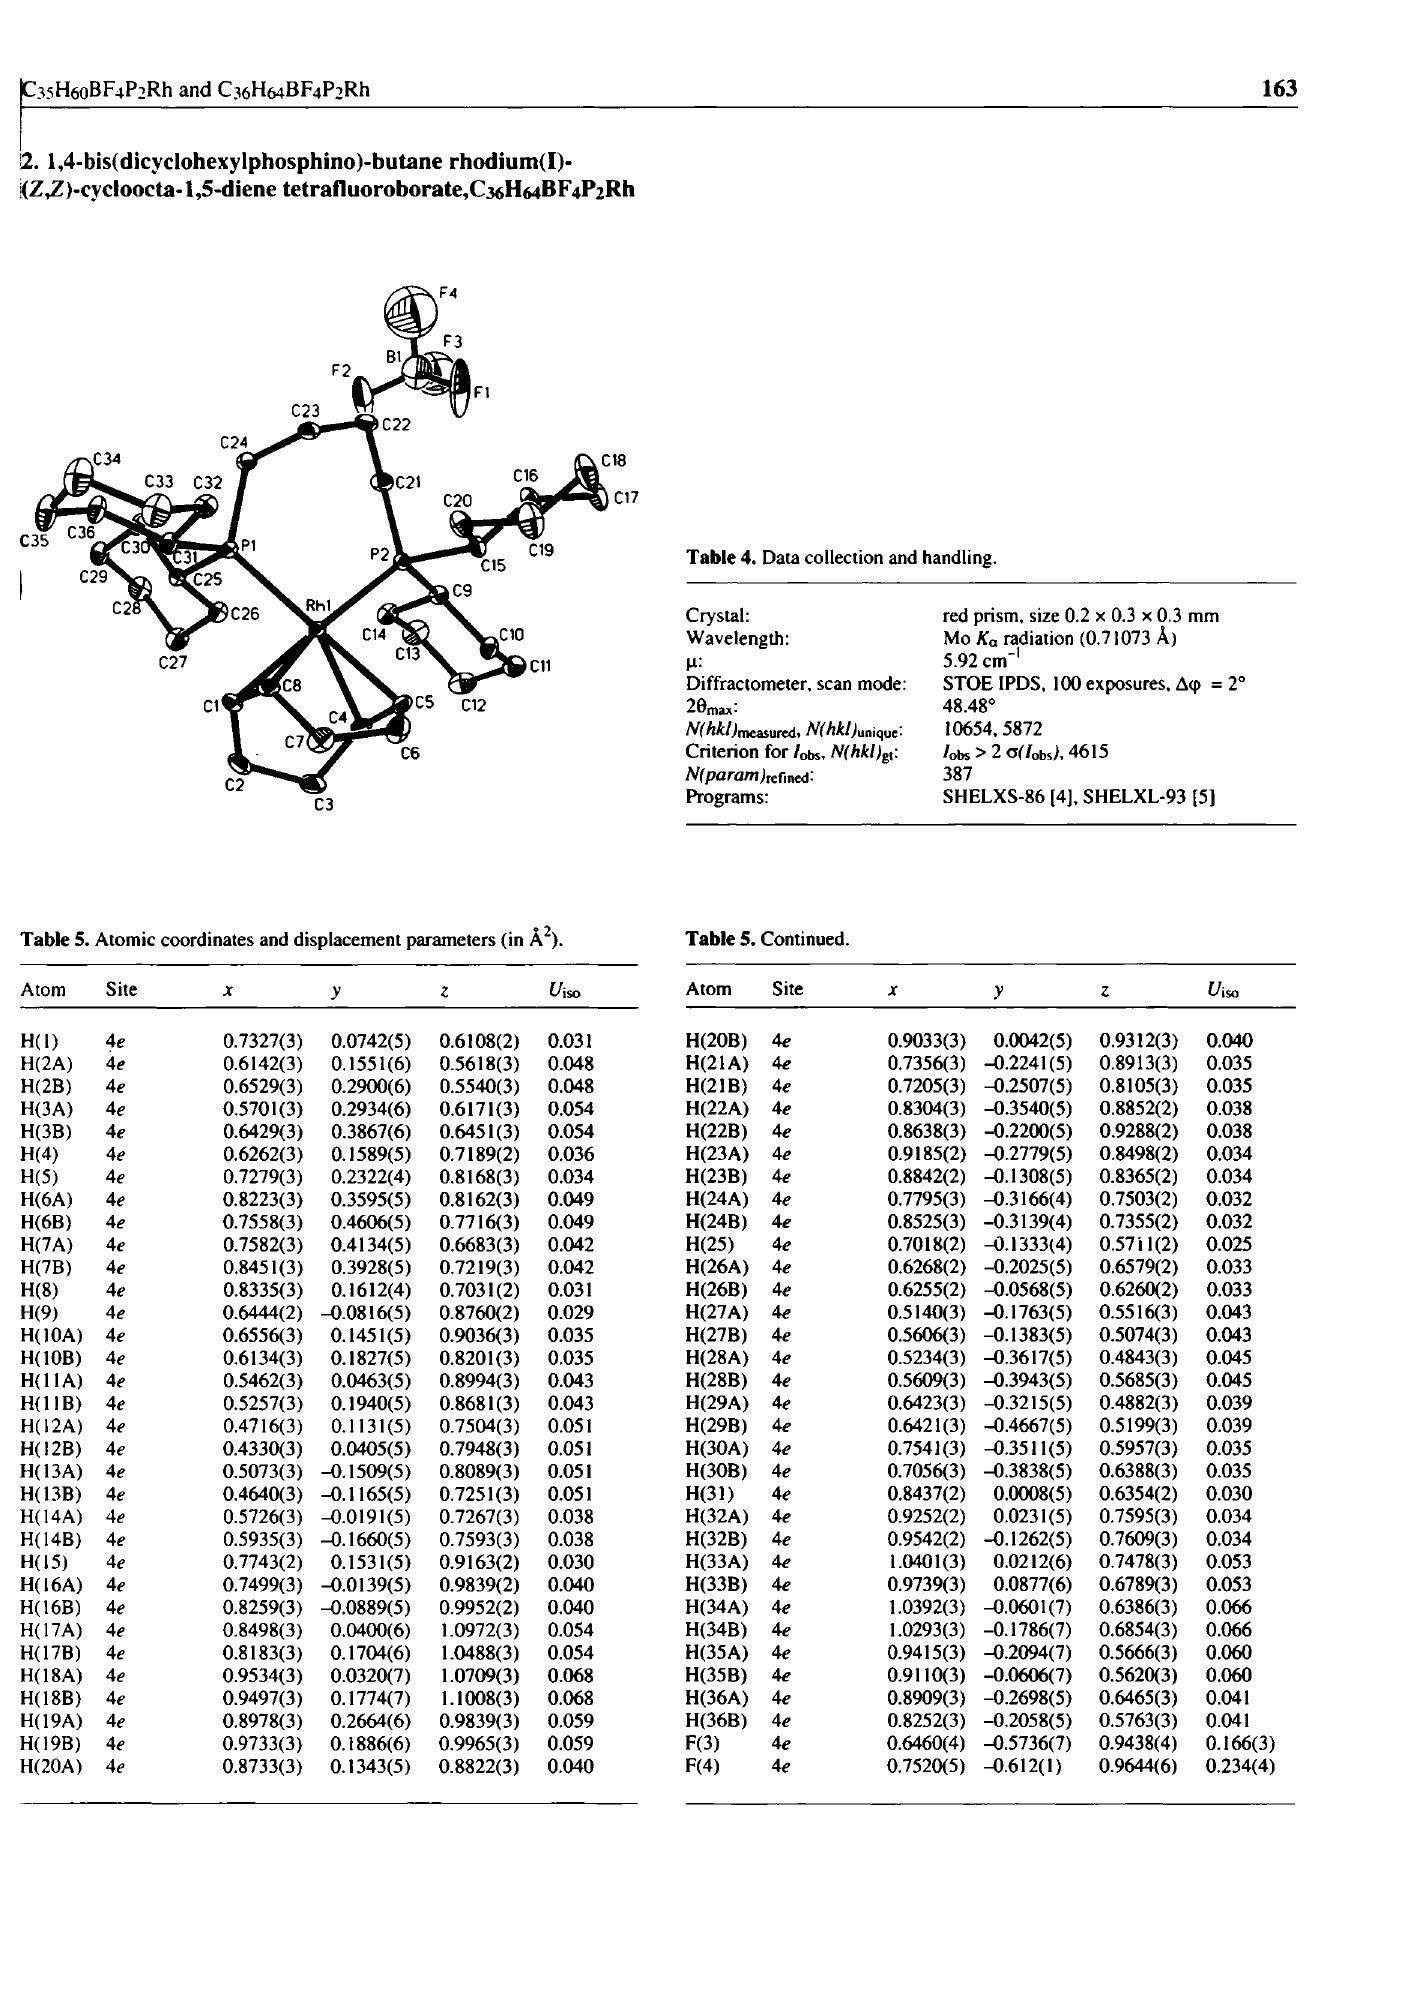
Table 5. Atomic coordinates and displacement parameters (in A 2 ). Table 5.